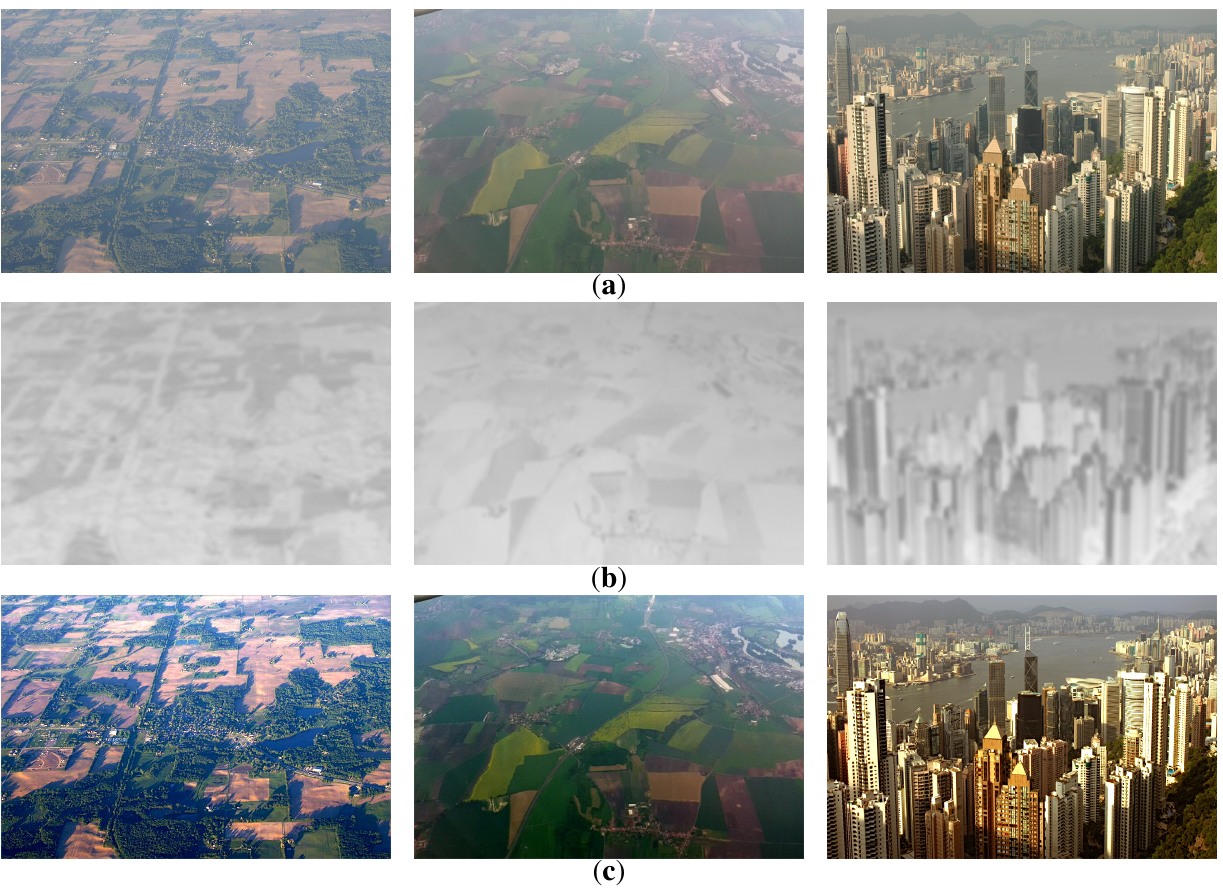
Figure 10. Experimental results of the proposed dehazing method: ( a ) input hazy UAV images; ( b ) the modified transmission maps; and ( c ) the dehazed UAV images using the proposed